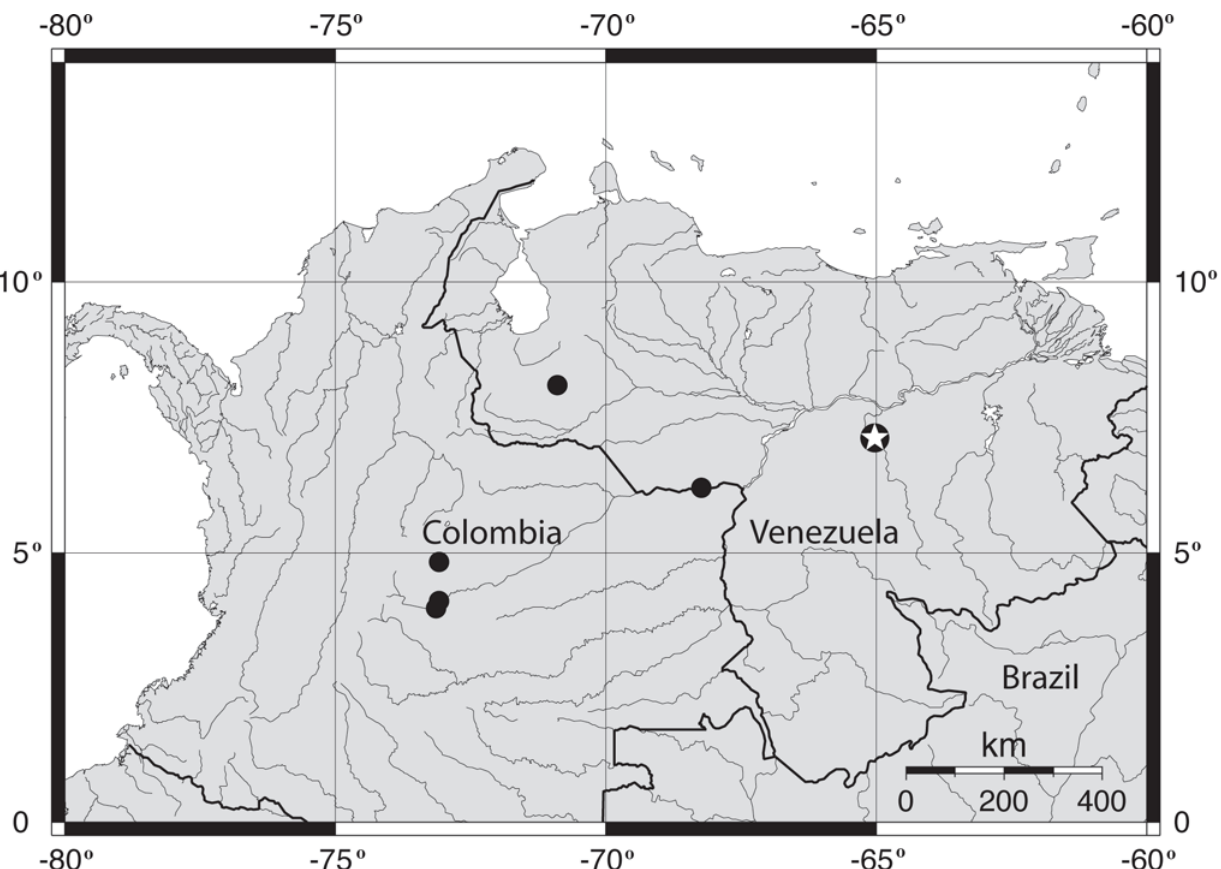
Fig. 5. Distribution map for Pseudobunocephalus lundbergi with the type locality indicated by a star